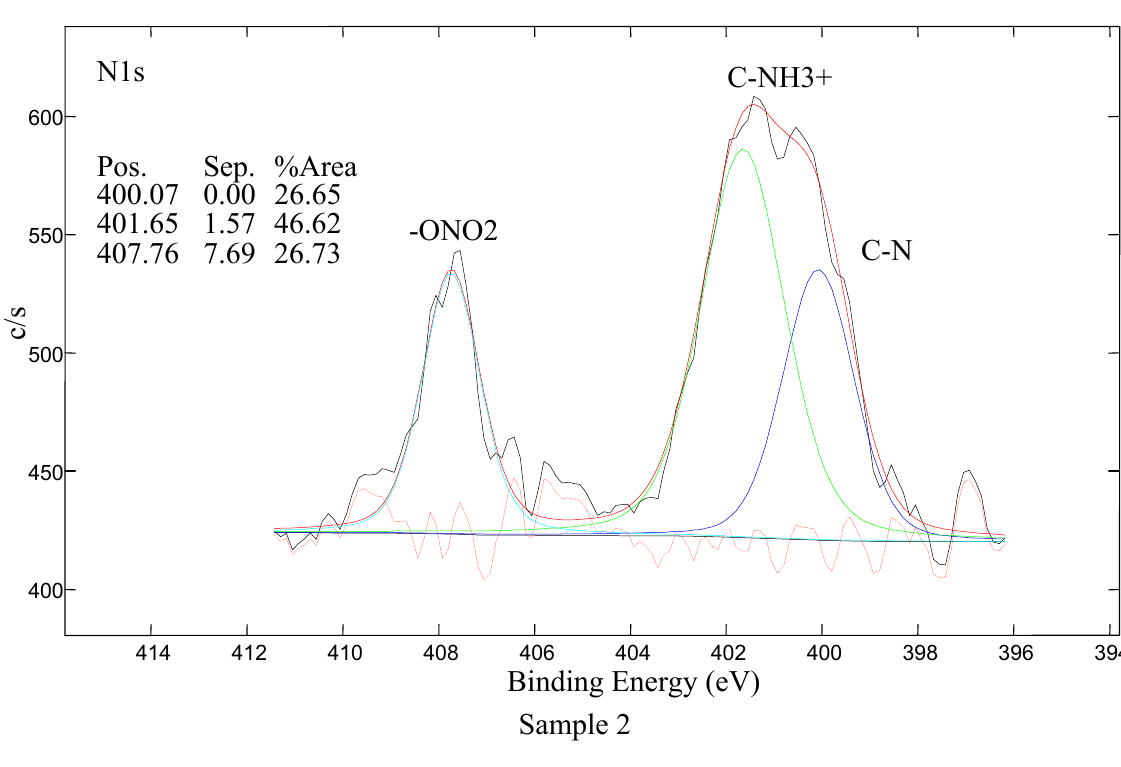
Figure 9. Nitrogen N1s peak for Sample 2 - plasma-treated.